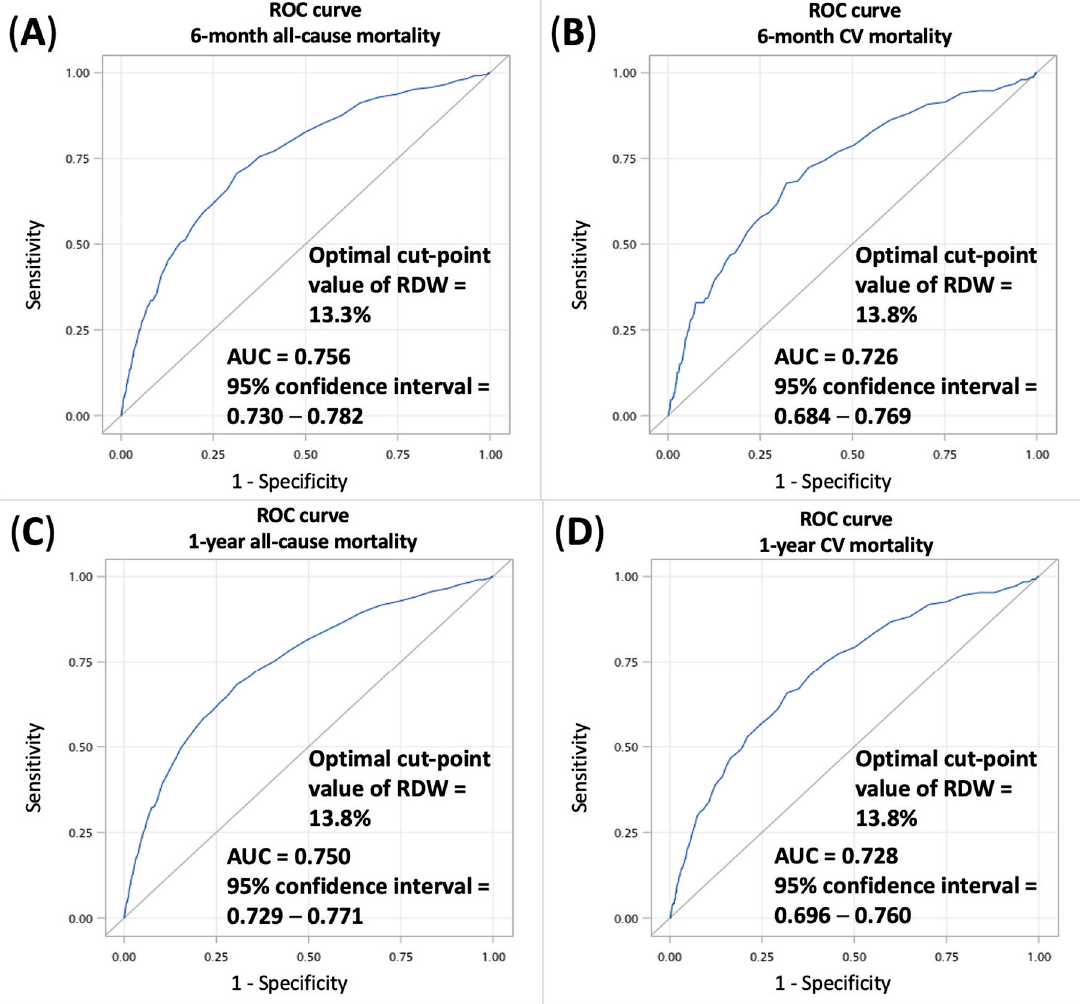
Figure 2. Receiver operating characteristic curves of ( A ) 6-month all-cause mortality; ( B ) 6-month cardiovascular mortality; ( C ) 1-year all-cause mortality; and ( D ) 1-year cardiovascular mortality in all study patients. Abbreviations: AUC, area under the receiver operating characteristic curve; CV, cardiovascular; ROC, receiver operating characteristic.